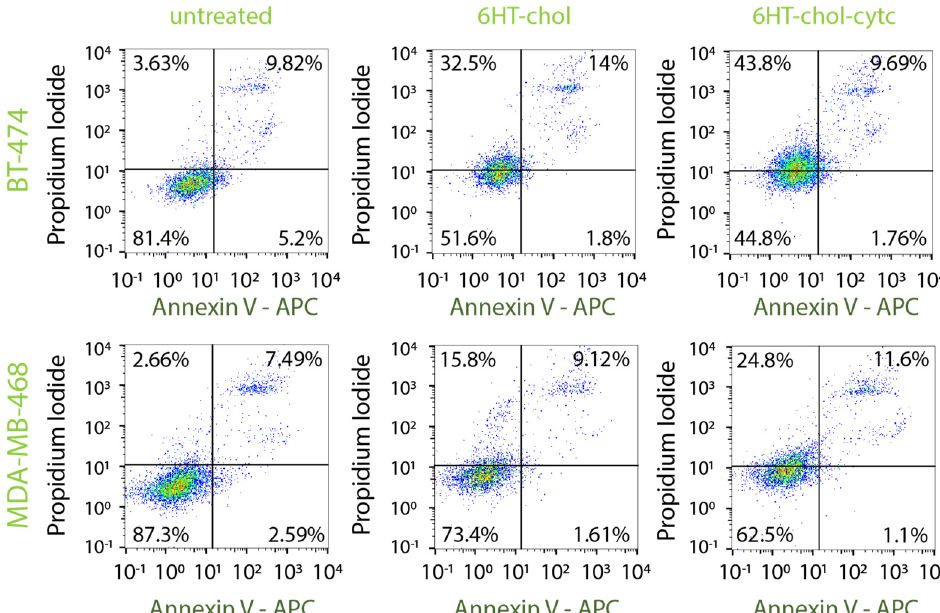
Figure A7. Viability of breast cancer cells (BT-474 and MDA-MB-468) after 24 h of incubation with cholesterol-conjugated DNA nanotubes. Flow cytometry analysis of the Annexin V/Propidium Iodide-stained cells 24 h after incubation with 1 µM cholesterol-modified DNA nanotubes. A cholesterol-dependent increase of the necrotic fractions in the cell populations was observed.